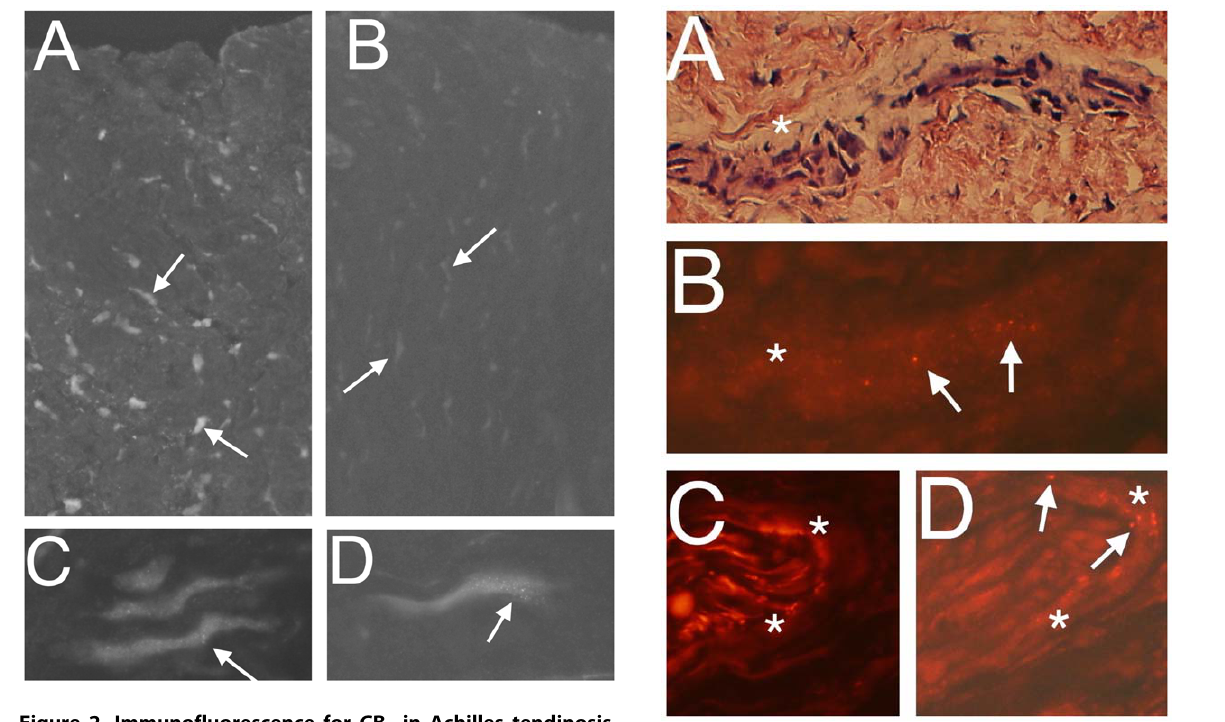
Figure 3. Immunofluorescence for CB 1 in blood vessel and nerve fasicle. Panels show sections of Achilles tendinosis tissue showing a small blood vessel ( a,b ) and a part of a nerve fascicle ( c,d ) stained with htx-eosin ( a ), processed for CB 1 IR ( b,d ), and for PGP9.5 ( c ). Immunoreactions (arrows) are seen in the blood vessel wall ( b ) and in the perineurium of the nerve fascicle (arrows) (d). Original magnification 6 20 ( a ), 6 40 ( c,d ), 6 63 ( b ). Asterisks in similar region in ( a ) and ( b ) and in the perineurium in ( c ) and ( d ).